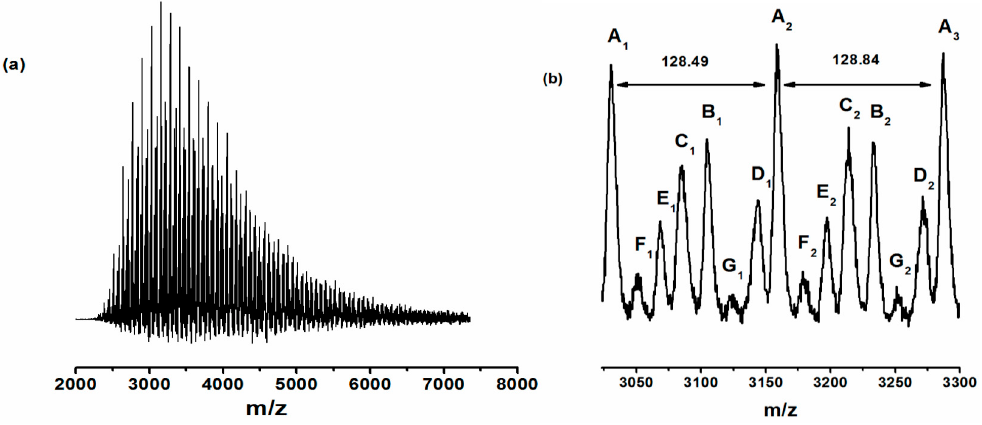
Figure 5. ( a ) Mass-assisted laser desorption ionization time-of-flight mass spectrometry (MALDI-TOF) spectrum and ( b ) enlarged spectrum of the hydroxyl-terminated PBA obtained by DITP of n -BA with feed molar ratio of [ n- BA]/[ACPO]/DIX = 16/0.5/1 in toluene at 60 °C for 24 h ( M n,GPC = 4280 g/mol).